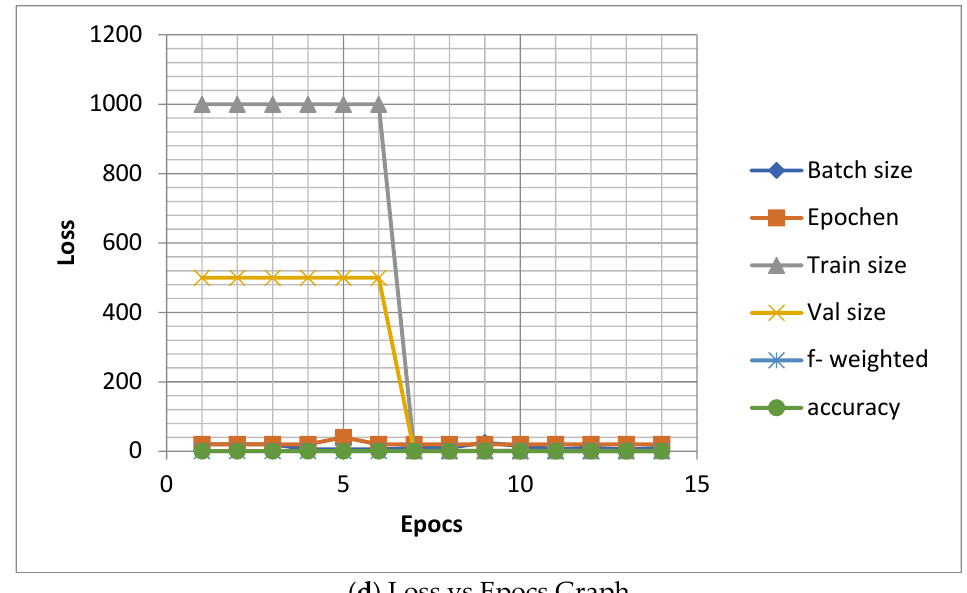
Figure 8. Model comparison: ( a ) Support vector machine, ( b ) Random forest, ( c ) Decision tree, ( d ) Loss vs Epocs Graph Table 2. Comparisionof different classifiers.